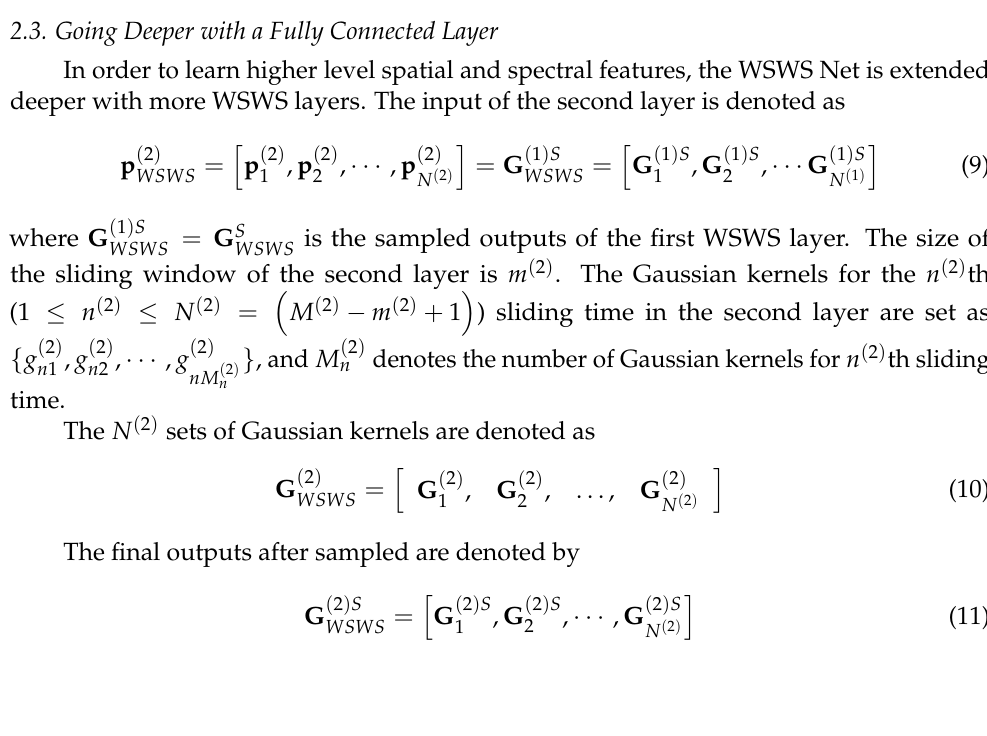
Figure 2. Constructing the wide sliding window and subsampling (WSWS) Layer by wide sliding window and